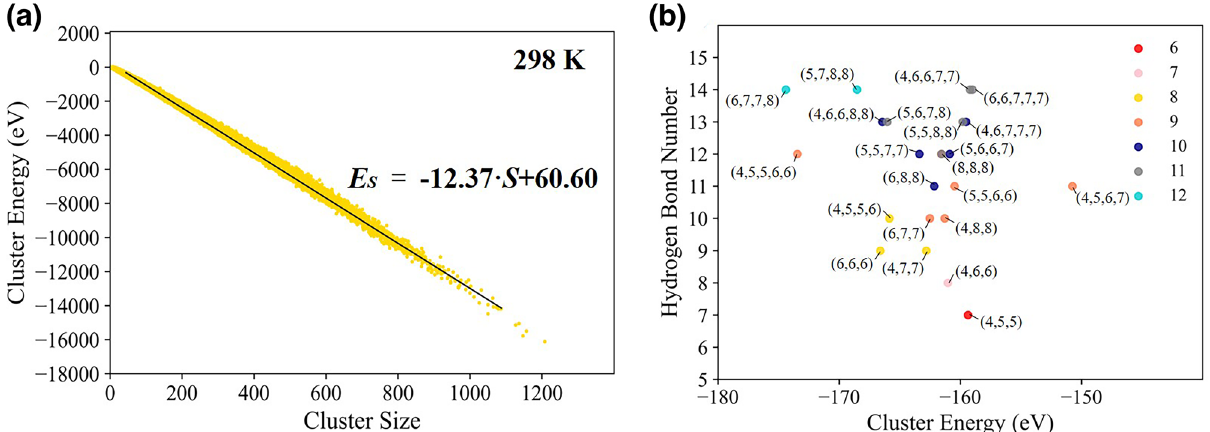
Figure 2. Scatter plots of cluster energy and cluster size and the relationship between cluster energy and cluster structures. ( a ) Scatter plots of cluster energy and cluster size at 298 K. The black line is the fit slopes by E S = a × S + b, where E S denotes cluster energy and S is cluster size. ( b ) The scatter of average cluster energy with certain cluster size and cluster structures. The colors represent cluster size. The labels of points represent ring components in a cluster.